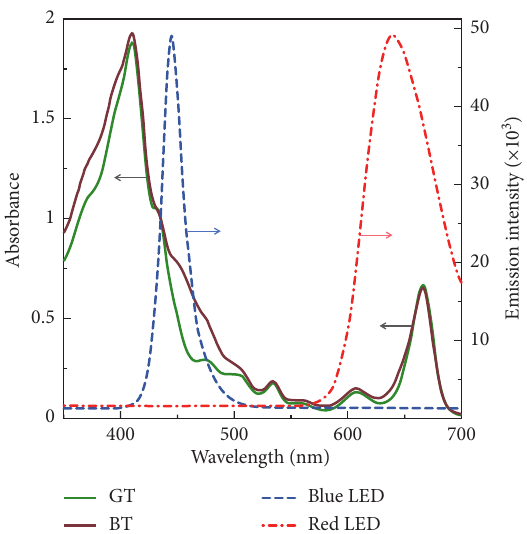
Figure 6: Absorption spectra of pigments extracted from the dregs of green (GT) and black teas (BT), being overlapped with the blue and red LED emission spectra. The arrows point to the axis for the marked